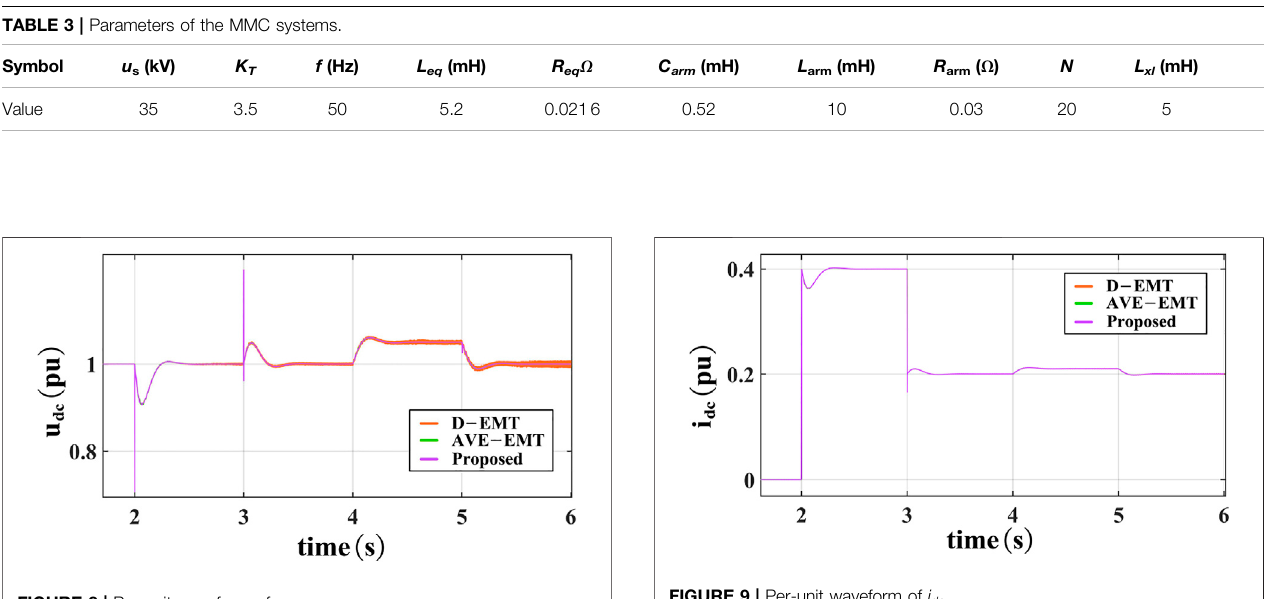
FIGURE 8 | Per-unit waveform of u dc . FIGURE 9 | Per-unit waveform of i dc .